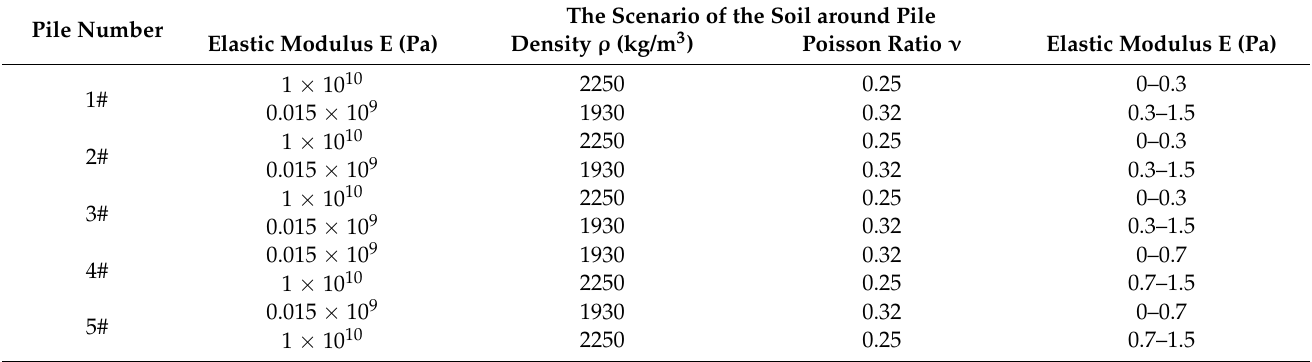
Figure 4. Model piles. Table 2. Scenario setting of the model